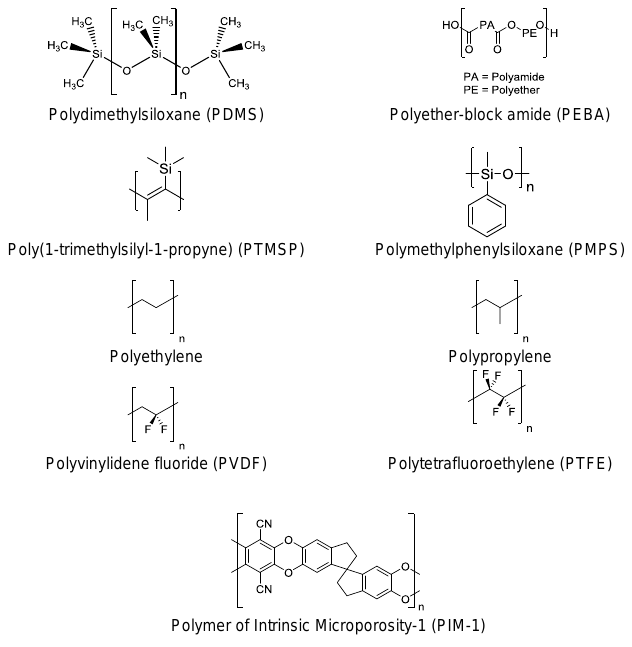
Figure 14. Examples of polymers for organophilic pervaporation membranes.